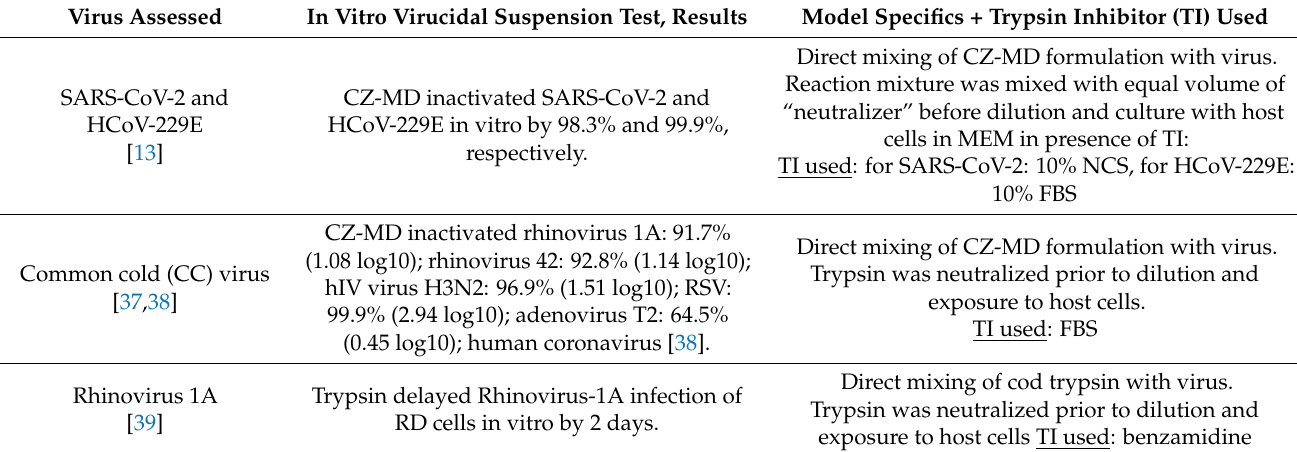
Table 1. Virucidal suspension tests for ColdZyme ® or Viruprotect ® (CZ-MD), nasal spray with cod trypsin. Virus Assessed In Vitro Virucidal Suspension Test, Results